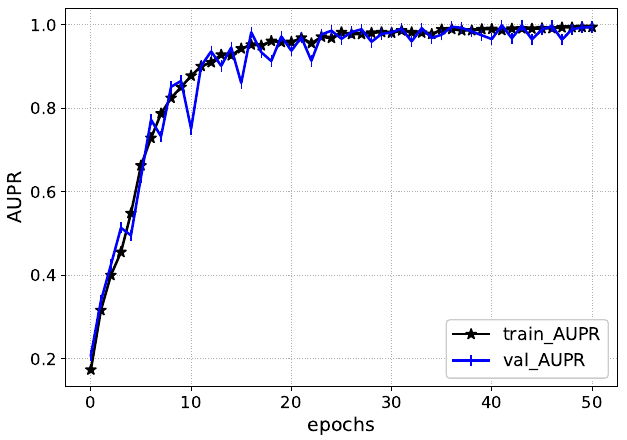
Figure 8. AUPR of Inception-V4 during execution.